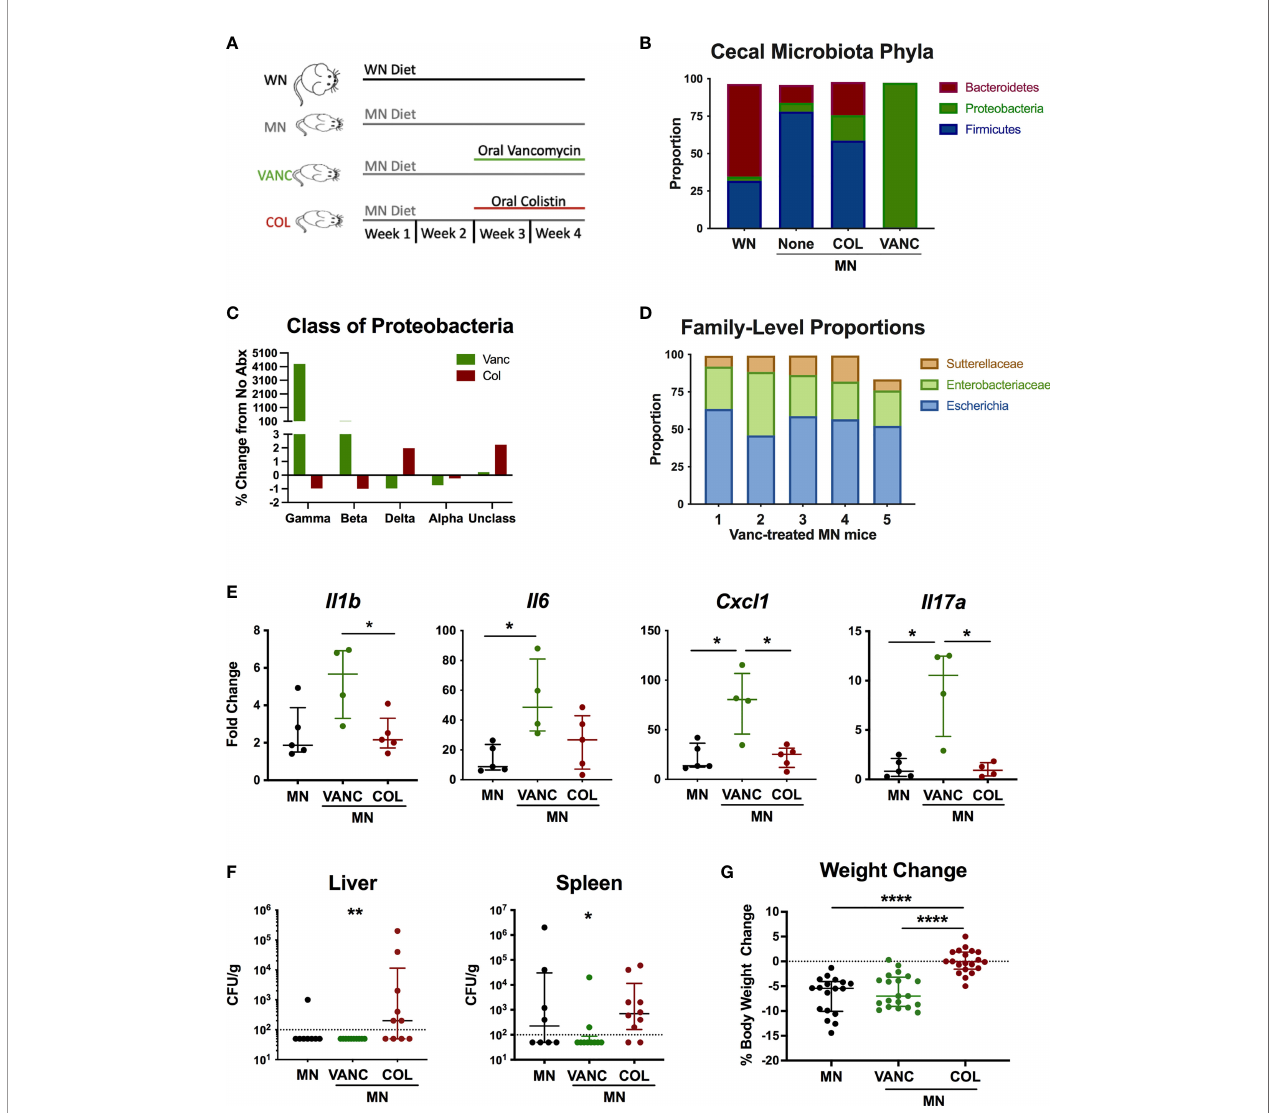
FIGURE 6 | Antibiotic-mediated reshaping of intestinal microbiota modulates bacterial translocation and systemic in fl ammation. (A) Graphic representation of experimental design in which well-nourished (normal diet; WN) and MN mice were given no antibiotic, or MN mice were given non-absorbable vancomycin (VANC) or colistin (COL) in drinking water over last two weeks of the 4-week diet. (B – D) Microbiota composition determined by bacterial 16S rDNA sequencing of cecal contents from control (WN) mice, and MN mice treated with no antibiotic (None), oral vancomycin (VANC), or colistin (COL) (n=5 mice per group). (B) Data are shown at the Phyla level. (C) Data are shown at the Class level as percent change from MN mice that received no antibiotic treatment. (D) Microbiota composition for 5 individual vancomycin-treated MN mice shown at the Family level. (E) Cytokine mRNA expression determined by qRT-PCR in skin of dorsal foot 24 hrs after intradermal LPS challenge of malnourished mice that had been treated with no antibiotic (MN) or oral vancomycin (VANC) or colistin (COL) (n=5 mice per group). (F) Quanti fi cation of culturable aerobic bacteria in the liver and spleen of untreated malnourished mice (MN) and malnourished mice treated with oral colistin (COL) or vancomycin (VANC). Live bacteria were quanti fi ed by plating tissue homogenates on BHI agar (n=4-5 mice per group). Data are pooled from 2 experiments with 4-5 mice per group and are presented as the median with interquartile range. (G) Change in body weight of malnourished mice treated with no antibiotic (MN) or oral vancomycin (VANC) or colistin (COL) in drinking water. Data pooled from 2 experiments with each having 8-10 mice per group. (*p < 0.05; **p < 0.01; ****p <